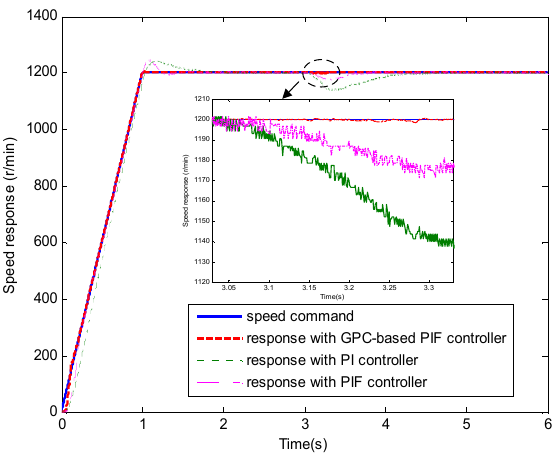
Figure 15. Speed error (test